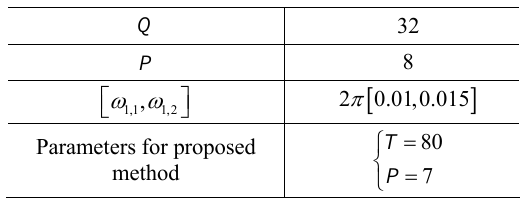
Table 3 simulation condition for multi-frequency offset